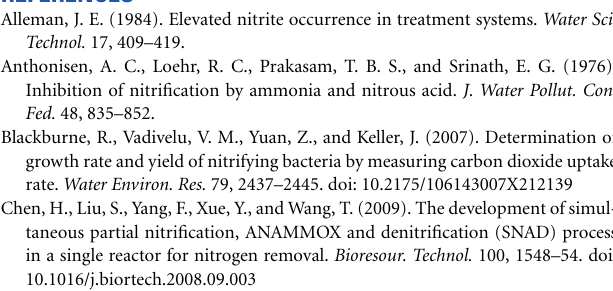
Table S1 | Primers used for PCR amplifications and